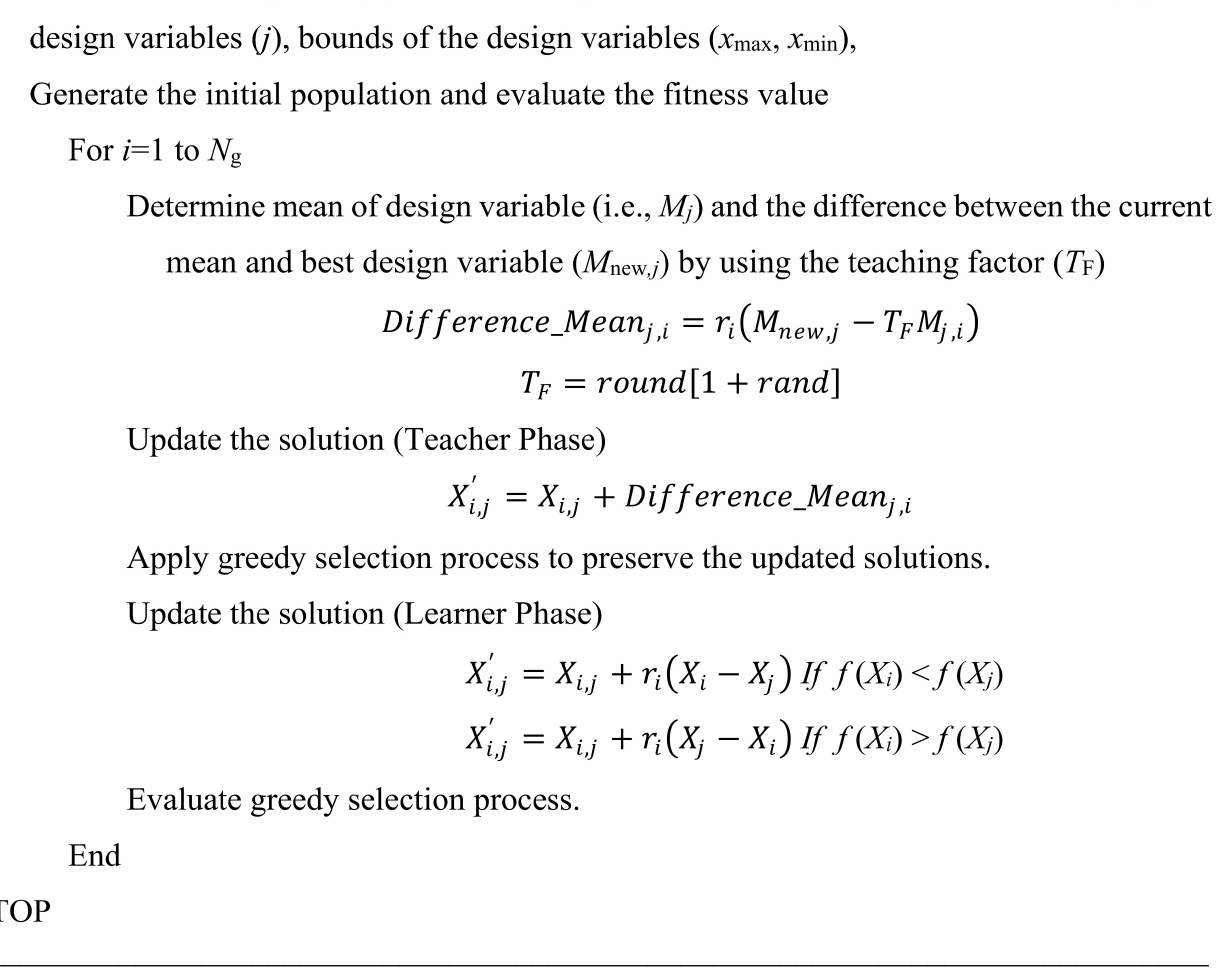
Figure 3. Pseudocode of the TLBO